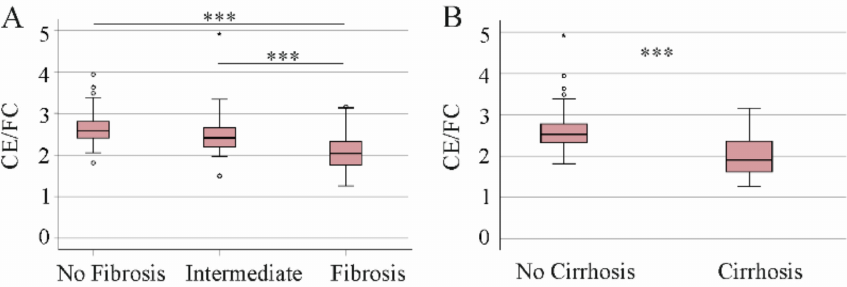
Figure 3. Cholesteryl ester (CE)/free cholesterol (FC) ratio in relation to the FIB-4 score and to cirrhosis diagnosed by ultrasound. ( A ) CE/FC ratio in the patients with no fibrosis, intermediate values and patients with fibrosis defined by the FIB-4 score. ( B ) CE/FC ratio in the patients without and with liver cirrhosis diagnosed by ultrasound. Small circles or asterisks above or below the boxes mark outlier. *** p < 0.001.